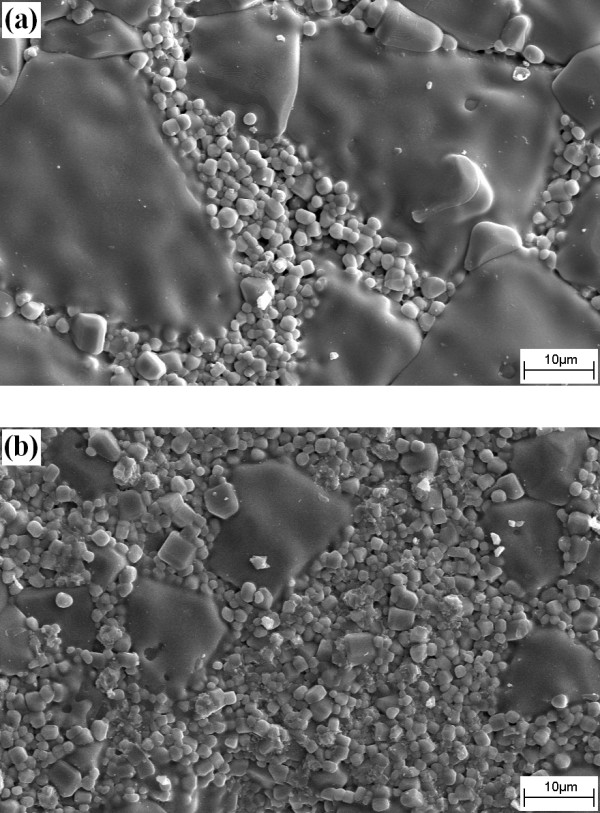
SEM micrographs of as-sintered surfaces of the CC3.1TO-Al2O3 nanocomposites. (a) CC3.1TO and (b) CC3.1TO and 2 vol.% Al2O3.